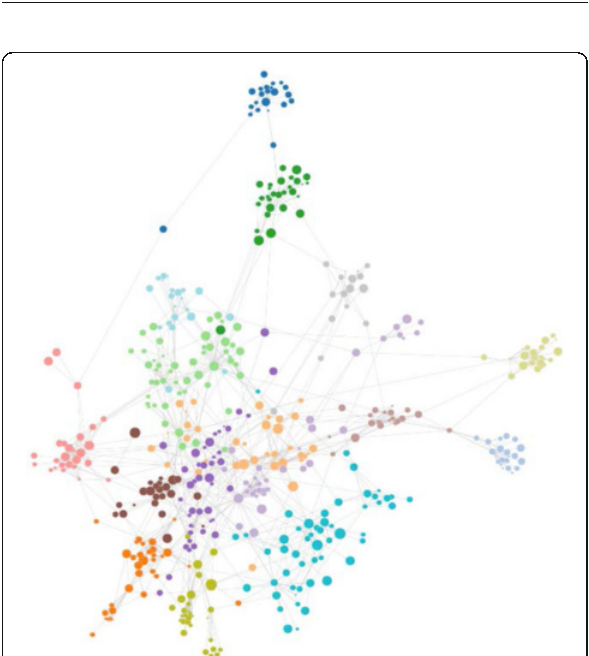
Fig. 5 (abstract A6). Coauthorship network for the field of neuroimaging. Each disk represent a single researcher with its radius encoding log 10 (Nc), where Nc is the number of citations. Edges stand for a binary relation of coauthorship between two